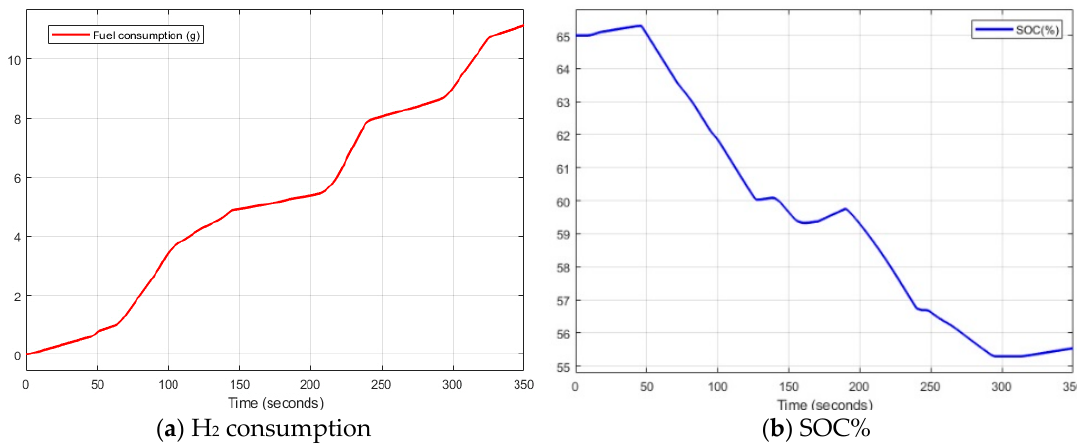
Figure 23. Performance of the fuzzy logic control strategy.